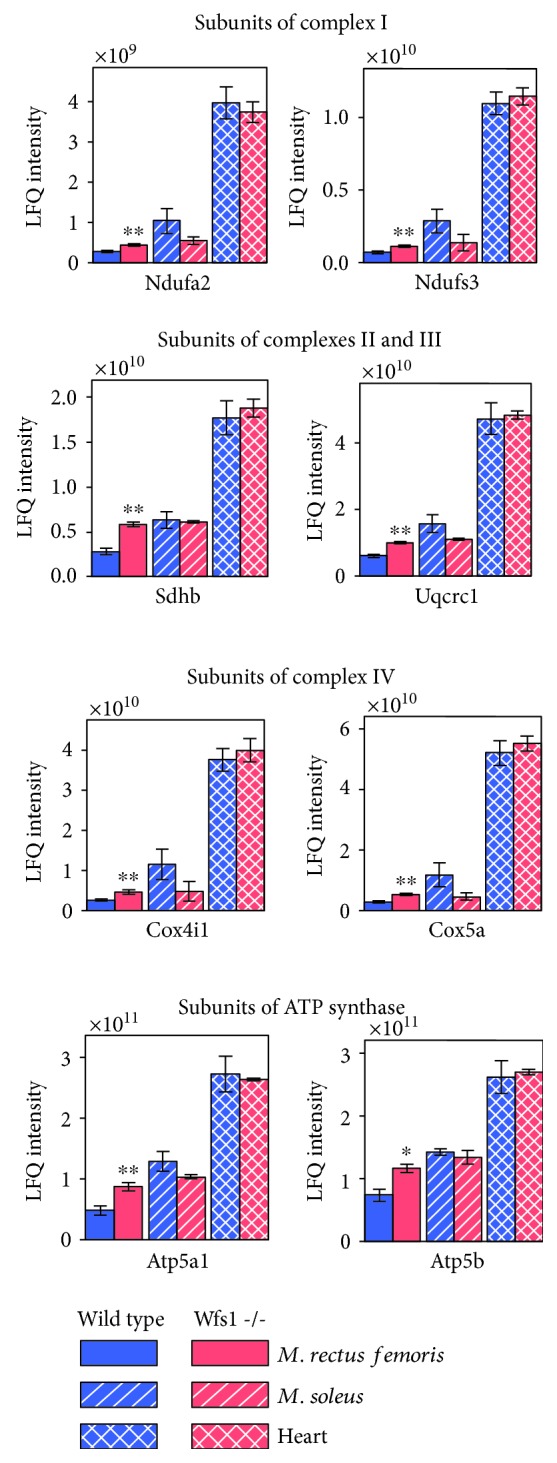
Amounts of some subunits of mitochondrial respiratory chain complexes. Ndufa2: NADH dehydrogenase [ubiquinone] 1 alpha subcomplex subunit 2; Ndufs3: NADH dehydrogenase [ubiquinone] iron-sulfur protein 3; SDHB: succinate dehydrogenase [ubiquinone] iron-sulfur subunit; Uqcrc1: cytochrome b-c1 complex subunit 1; Cox4i1: cytochrome c oxidase subunit 4 isoform 1; Cox5a: cytochrome c oxidase subunit 5A; Atp5a1: ATP synthase subunit alpha; Atp5b: ATP synthase subunit beta. Compared to wild type: ∗
P < 0.05 and ∗∗
P < 0.01.